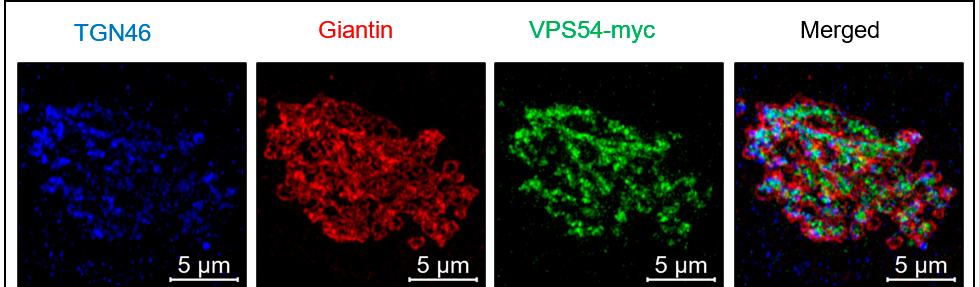
Figure 2. GARP is localized to trans -Golgi/TGN in human cells. hTERT–RPE1 VPS54 knock out cells stably expressing mVPS54–13myc were stained with antibodies to TGN protein TGN46, cis/medial Golgi protein Giantin and myc (VPS54). Airyscan super-resolution images (MIPs of 14 z-stack) were collected with 63x oil 1.4 NA objective on Zeiss LSM880.